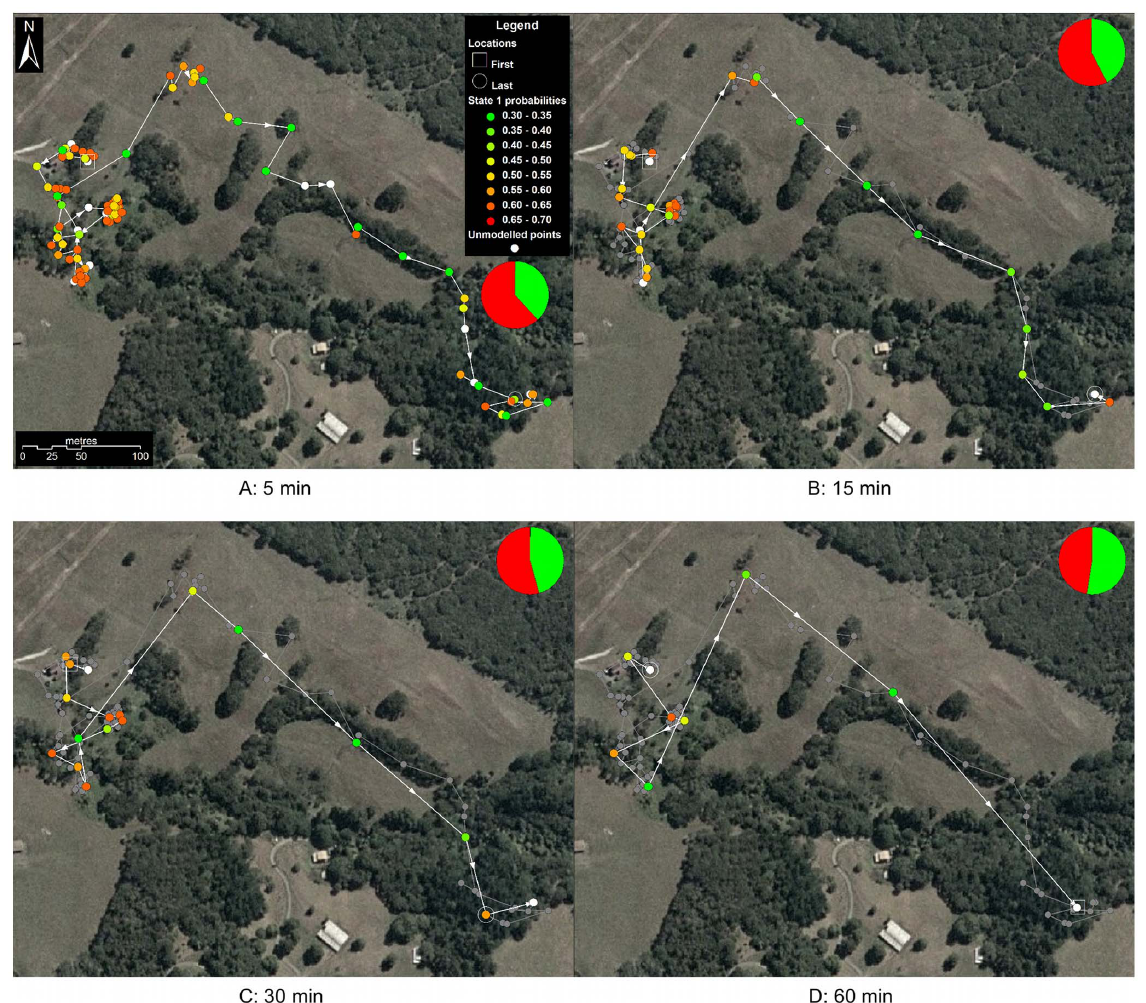
Figure 7. Data from a single night’s activity of possum # 1882. Example of a nightly movement trajectory of possum # 1882 at sub-sampling intervals of 5, 15, 30 and 60 min. Inferred behavioural states are shown for each location estimated by the two-state model. Panel (a) shows the original trajectory as recorded at 5-min intervals from a GPS collar. Panels (b–d) indicate sub-samples of the original trajectory at progressively larger intervals (15, 30, and 60 min, respectively). Piecharts show the proportions of the two behavioural modes (red is ‘slow-area-restricted’, green is ‘fast- directed’). In this example, it is obvious that as sub-sampling interval increases, the proportion of ‘slow-area-restricted’ behaviour correspondingly decreases (by 25%). The figure also demonstrates the considerable loss of information about behaviour at larger sampling